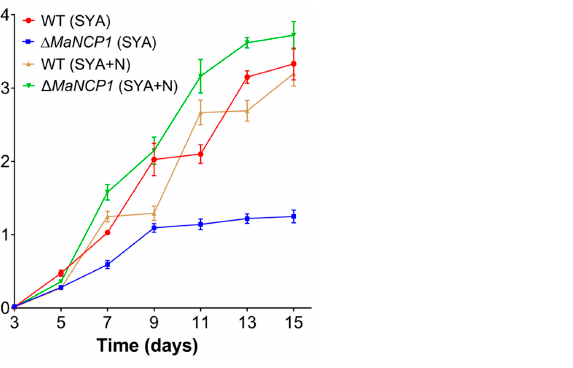
Figure 1. Conidial yields of the WT and ∆ MaNCP1 strains under SYA or SYA+N conditions. SYA+N, SYA supplemented with sodium nitrate.